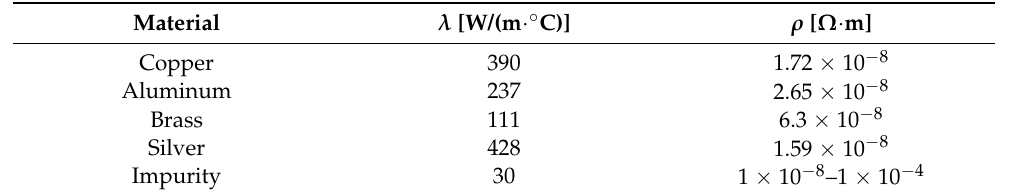
Table 4. Material properties of selected individual materials [22].